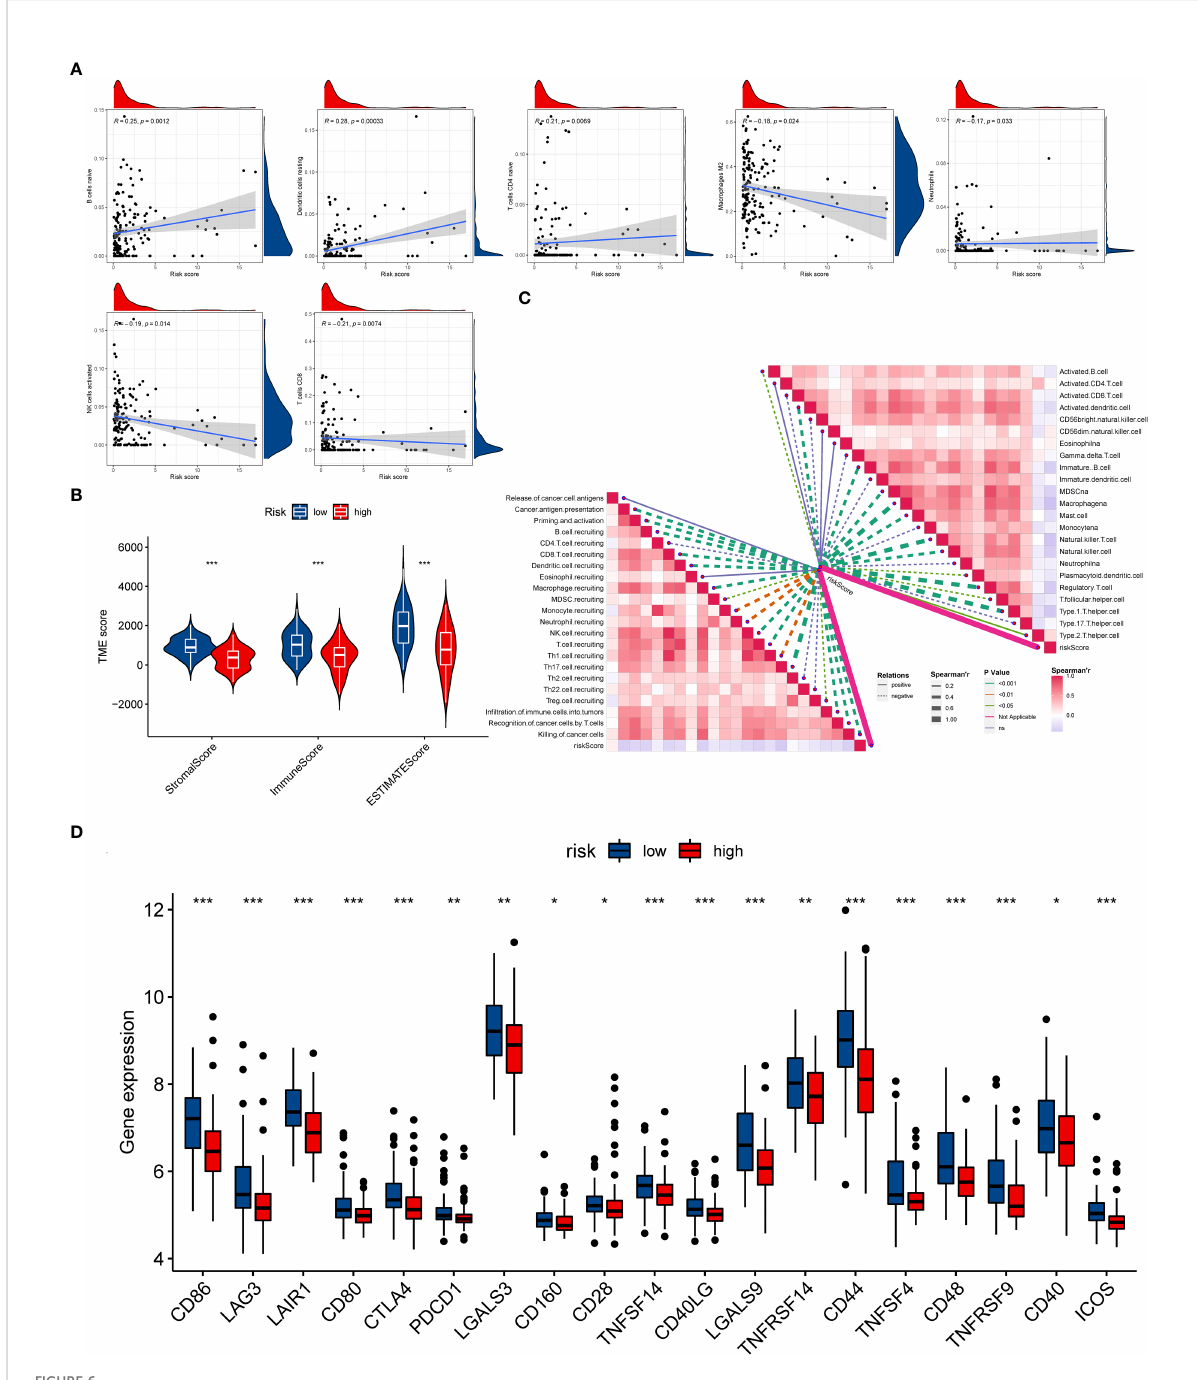
FIGURE 6 The evaluation of the immunity statute and checkpoints between the two distinct ICD risk groups. (A) The association between ICD-related signature and immune cell in fi ltration. (B) The difference in TME score between the two ICD risk groups. (C) Correlation of ICD risk score with immune cells and immune functions in OS. (D) The comparison of immune checkpoint expression between the low- and high-risk group. ICD, Immunogenic cell death; OS, Osteosarcoma; TME, tumor microenvironment. *p < 0.05, **p < 0.01, ***p <